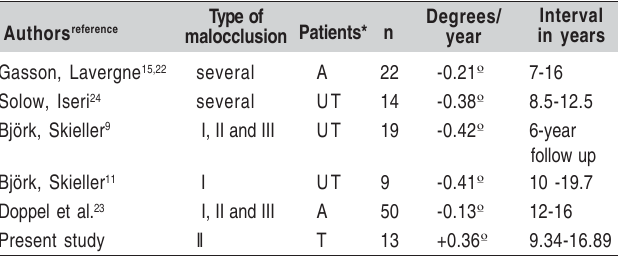
Table 8 . Yearly changes in the maxillary total rotation in studies on metallic implants – available